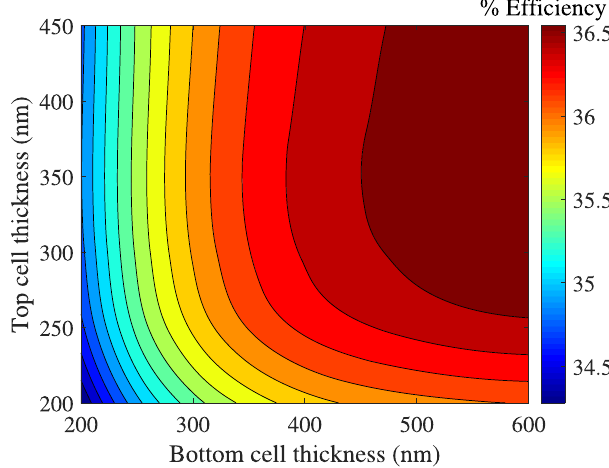
Fig. 8. 4T tandem solar cell ef fi ciency for different thicknesses of top and bottom cells, without considering trap-assisted recombi- nation losses. The bandgaps of the top and bottom cells are fi xed at 1.55 eV and 1.0eV,